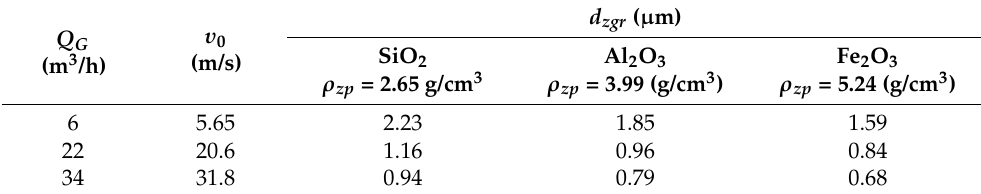
Table 2. Results of calculations of the limit size d pgr of the dust grains.